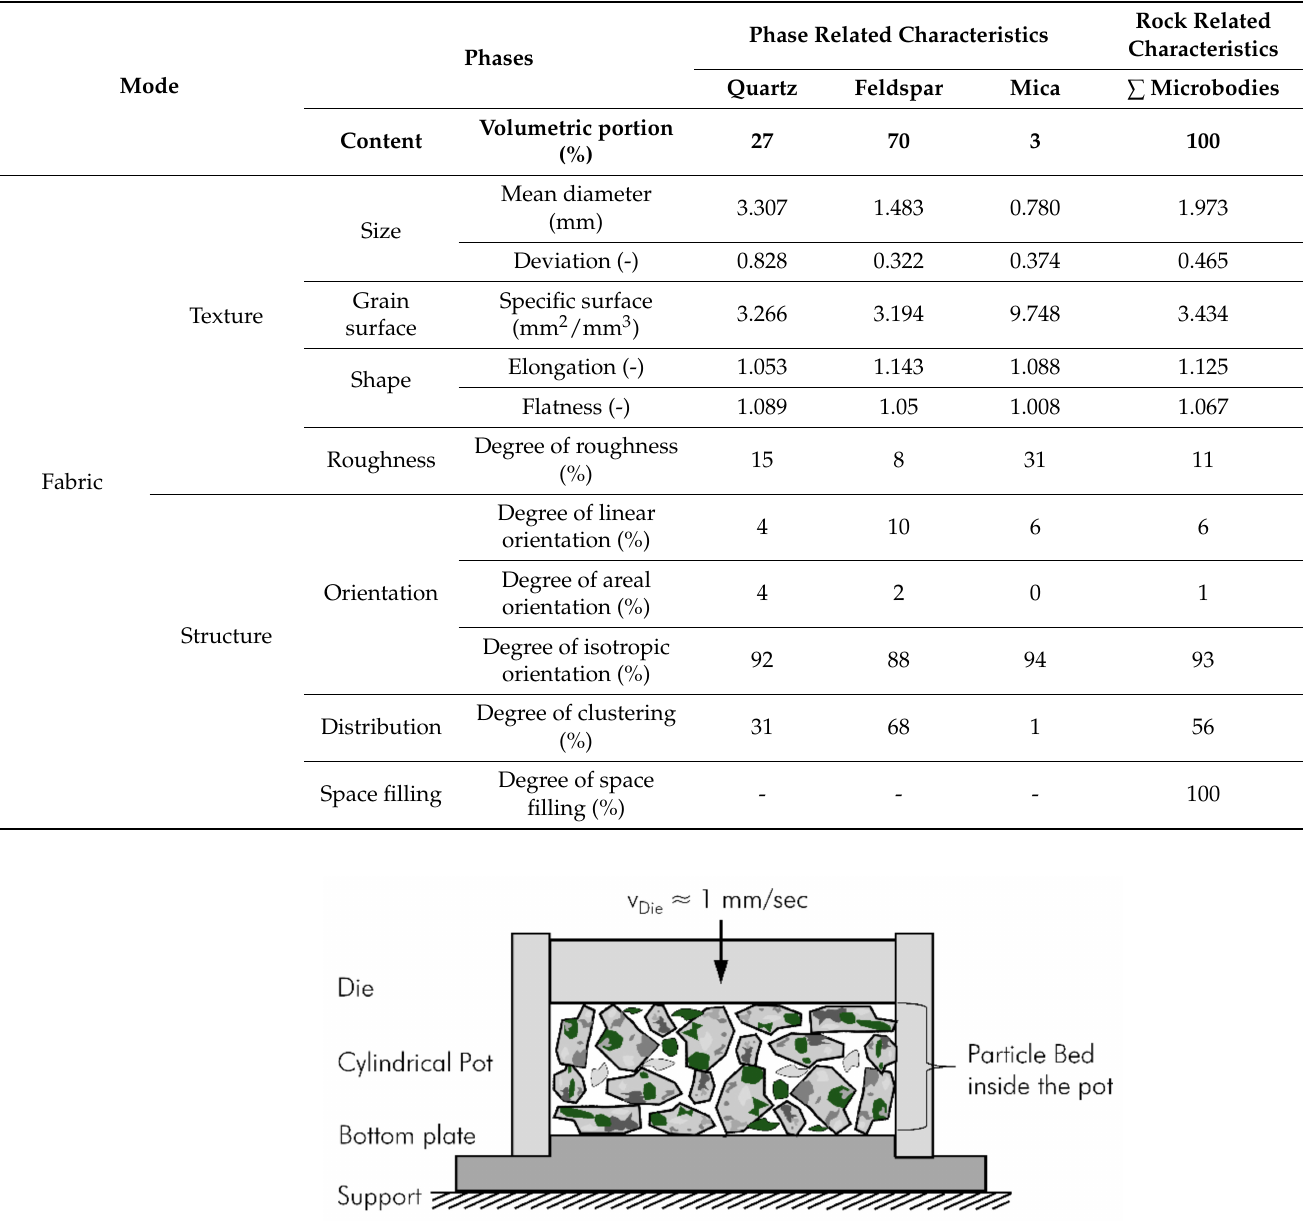
Table 1. Quantitative mineralogical analysis (QMA) results for the granite from Meissen, Saxony [27].